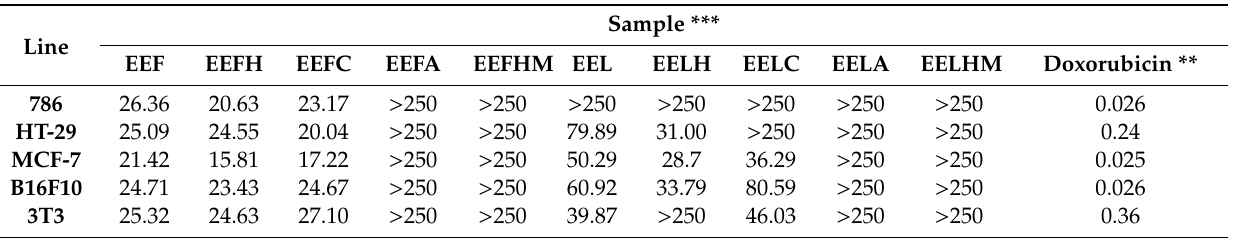
Table 5. Cytotoxic activity, GI 50 values* ( µ g / mL), for extracts and fractions of fruits and leaves of Garcinia gardneriana , lines 786 (kidney carcinoma), HT-29